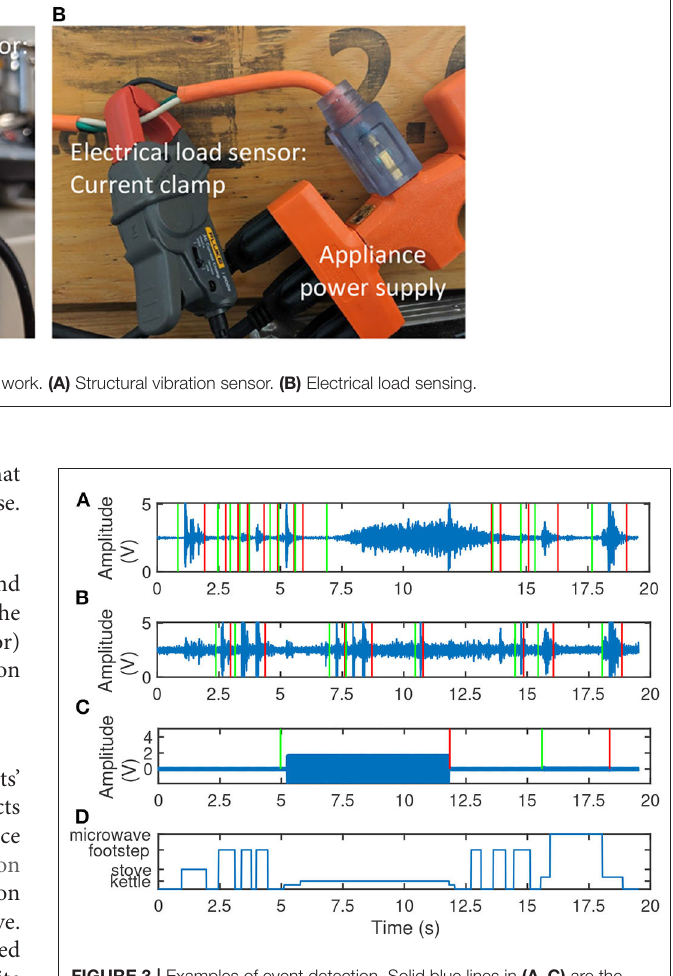
FIGURE 3 | Examples of event detection. Solid blue lines in (A–C) are the sensor signals. Green lines mark the beginning of events, and red lines mark the end of events. (A) Countertop Vib. (B) Floor Vib. (C) Electrical load. (D)